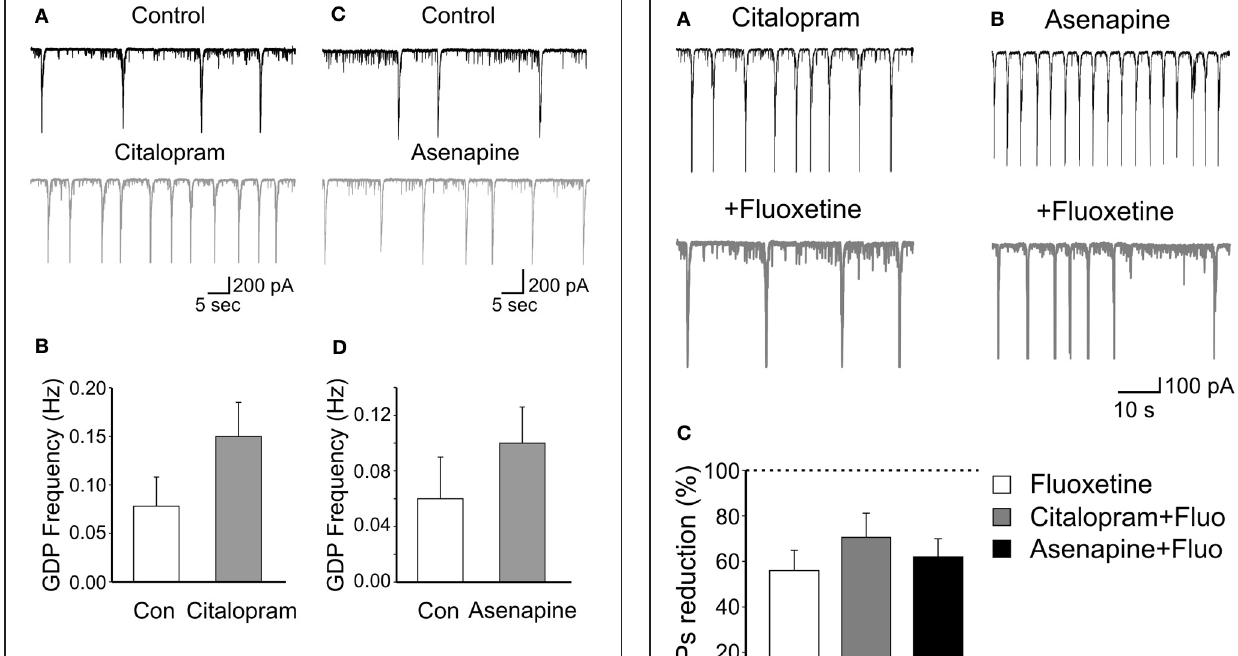
0 . 9 ± 0 . 04 Hz, before and during fluoxetine, respectively ( n =